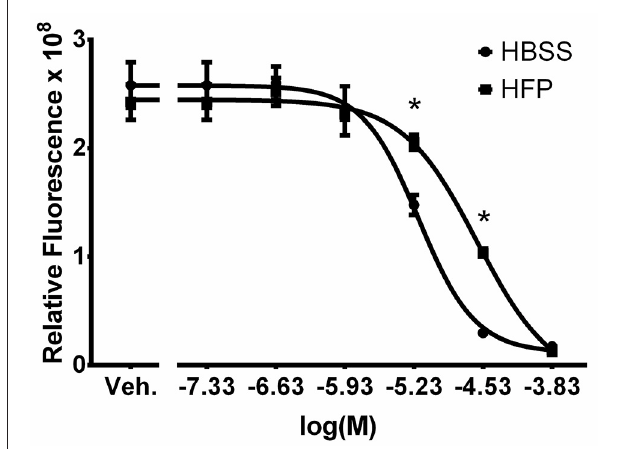
FIGURE 2 | Cl-Am retains activity after exposure to HFP. Plot of drug concentration against relative fluorescence for HBSS and HFP exposed samples. Vehicle (Veh.) is HBSS only. The four-parameter regression of the HFP exposed samples has no evidence of lack of fit ( p = 0.28). *Significant difference in relative fluorescence ( p < 0.05) (mean ± std. dev., n = 4).